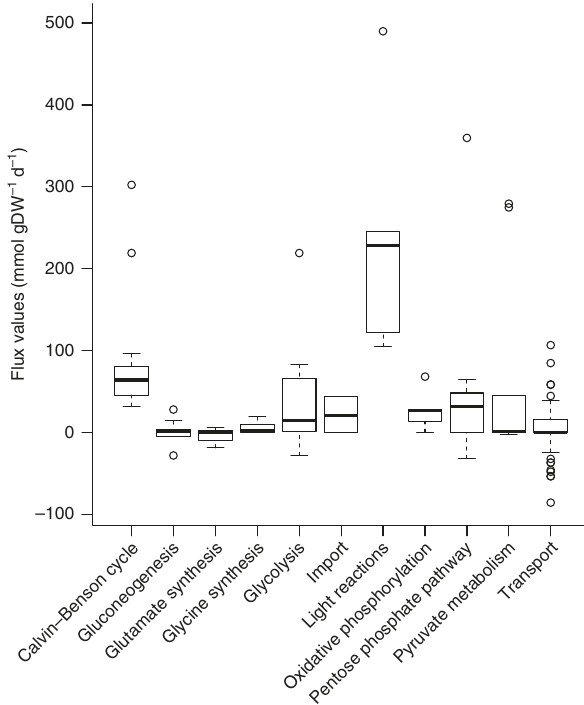
Fig. 2 Flux ranges of metabolic systems in the metabolic model of A. thaliana . The metabolic systems with the most variable fl uxes are shown in the x-axis. Largest variation is exhibited for glycolysis, photosynthesis light reactions, and pentose phosphate pathway. The remaining metabolic systems exhibit small fl uxes, small variations, or both (Supplementary Fig. 3). n = 3 to 76 fl uxes in each metabolic system are used. Center line, median; box limits, 75th and 25th quartiles; whiskers, 1.5×interquartile range; points, outliers. Source data are provided as a Source Data fi